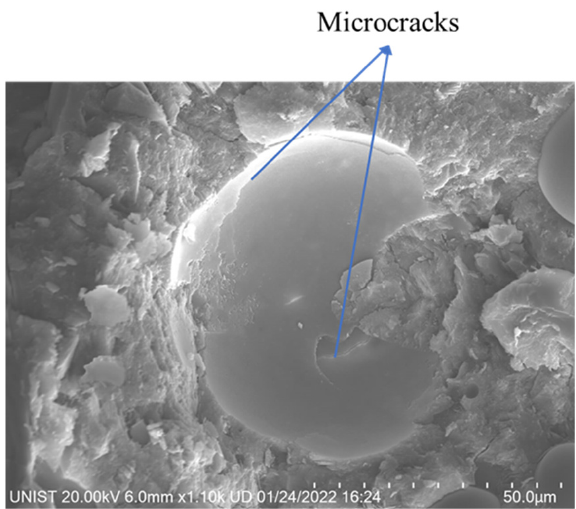
Figure 9. Trapped water in the HGM particles.